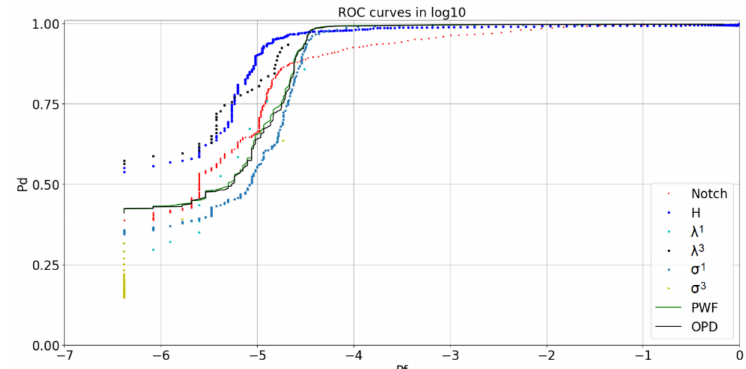
Figure 14. Iceberg detection ROC curves for sea ice, target window 15 × 15, clutter window 255 × 255 with a guard window of 205 × 205. Notch means the polarimetric notch filter, H means entropy, λ λ 1 and 3 are the first and third eigenvalues of the covariance matrix, polarimetric match filter, PWF means the polarimetric whitening filter, and OPD means the optimal polarimetric detector.